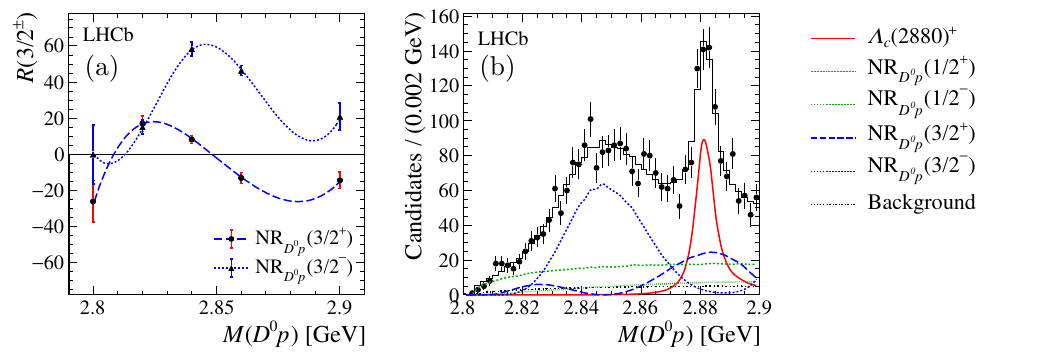
Figure 12 . Results of the (cid:12)t including the (cid:3) c (2880) + state, two exponential nonresonant ampli- tudes with J P = 1 = 2 (cid:6) and two real splines in J P = 3 = 2 (cid:6) partial waves. (a) Spline amplitudes for J P = 3 = 2 (cid:6) partial waves as functions of M ( D 0 p ). Points with the error bars are (cid:12)tted values of the amplitude in the spline knots, smooth curves are the interpolated amplitude shapes. (b) The M ( D 0 p ) projection of the decay density and the components of the (cid:12)t